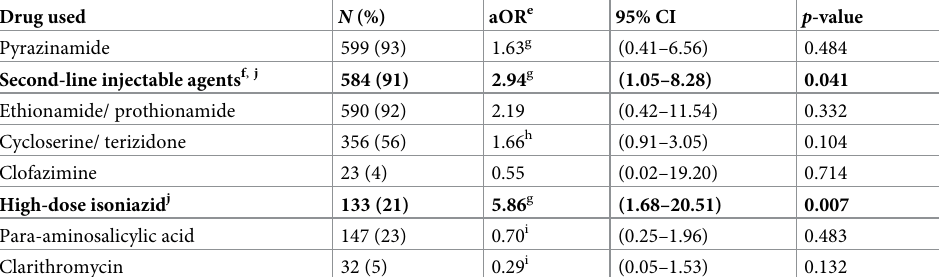
Table 6. Summary of association of use of individual drugs with treatment success in children treated for con- firmed MDR-TB ( n = 641) a,b,c,d